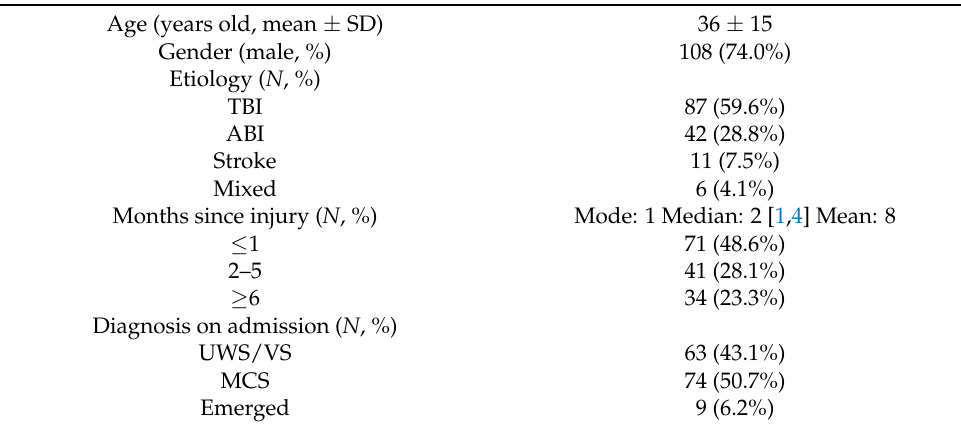
Table 1. Demographics of the 146